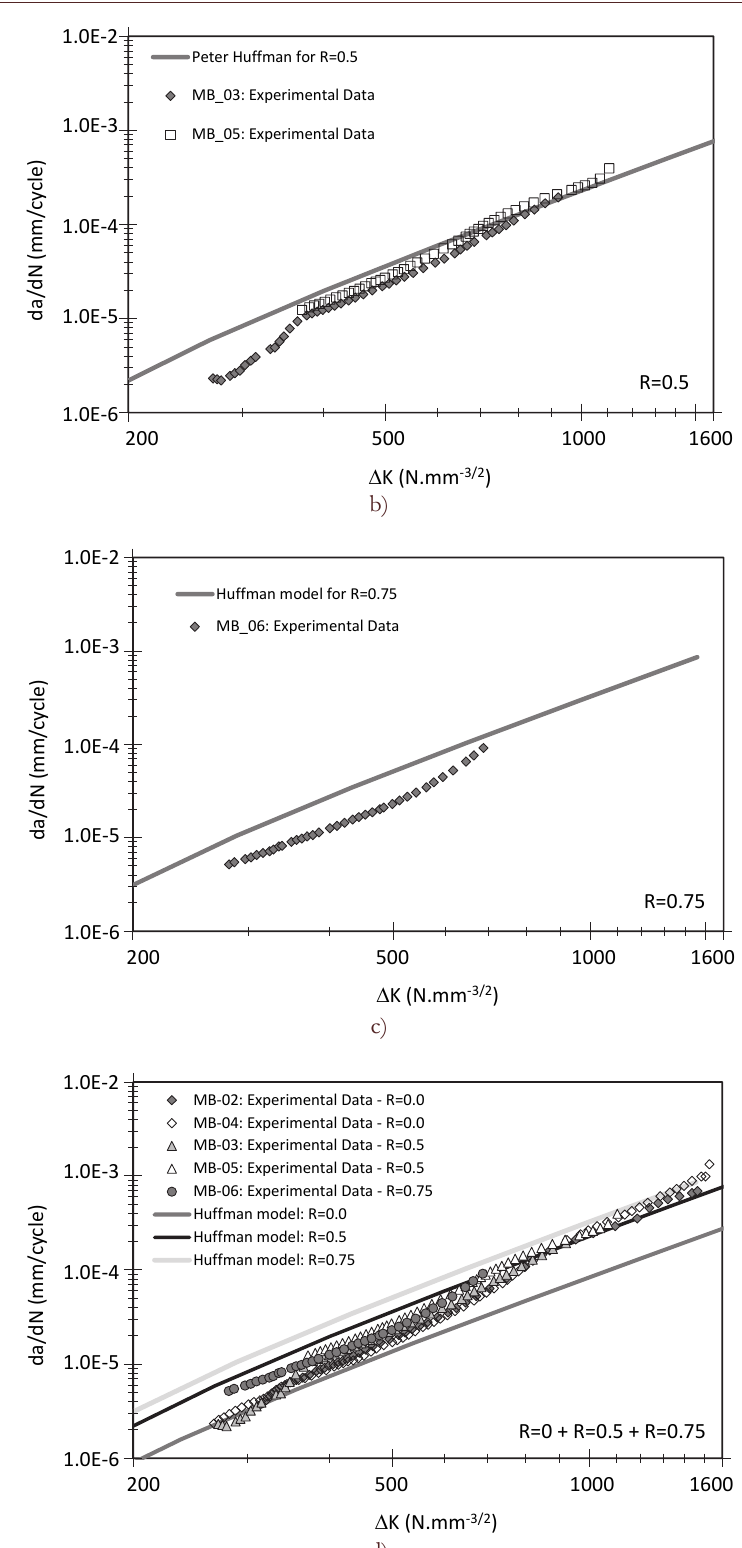
Figure 6. Fatigue crack growth rate of P355NL1 steel obtained using the Huffman model, as per reference [1]: a) R=0; b) R=0.5; c) R=0.75; d) R=0 + R=0.5 +